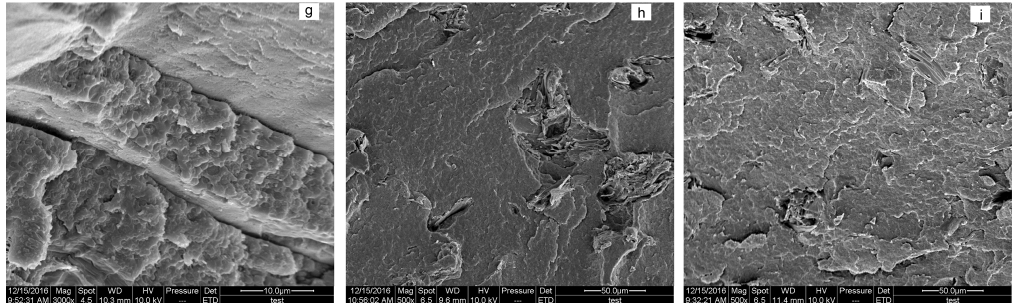
Figure 5. Morphologies of the composites in various LiCl contents and scale bar: ( a ) 0% (10 μ m); ( b ) 0.5% (10 μ m); ( c ) 1.0% (10 μ m); ( d ) 1.5% (10 μ m); ( e ) 2.0% (10 μ m); ( f ) 2.5% (10 μ m); ( g ) 3.0% (10 μ m); ( h ) 0% (50 µ m); and ( i ) 2.0% (50 µ m).